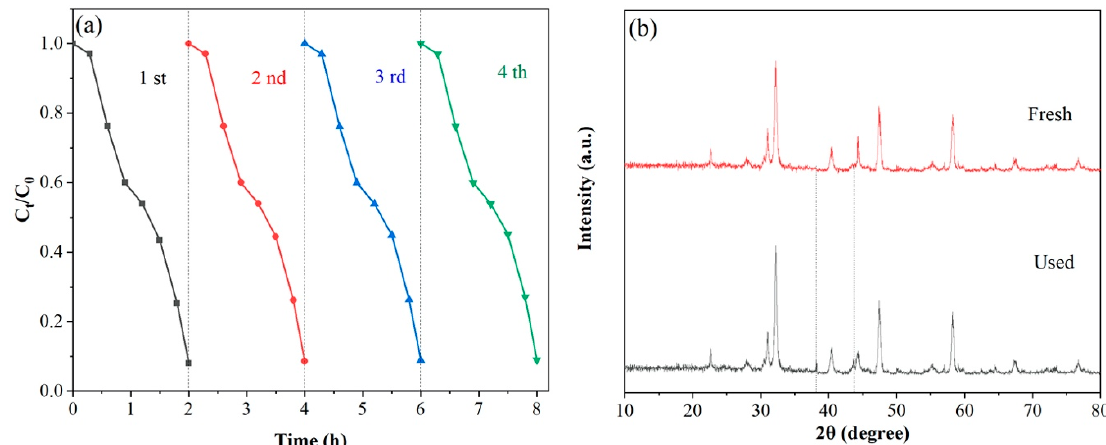
Figure 10. Recycling experiments ( a ) of the photocatalytic degradation of NOR over 3-ALG and ( b ) patterns of 3-ALG before and after sequential photocatalytic reaction under visible irradiation.